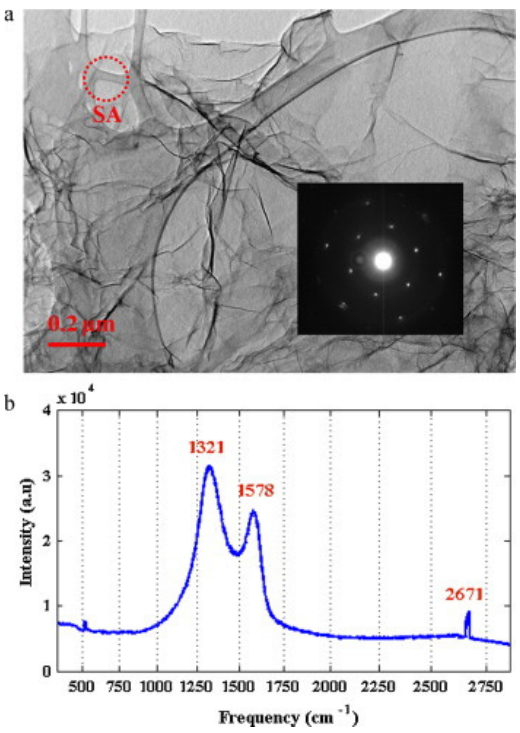
Figure 10. ( a ) Transmission electron microscopy (TEM) image of GNP with the wrinkled morphology; ( b ) Raman analysis of as ‐ received GNPs, SAD (selected area diffraction), reproduced from [68], with permission from Elsevier, 2018.